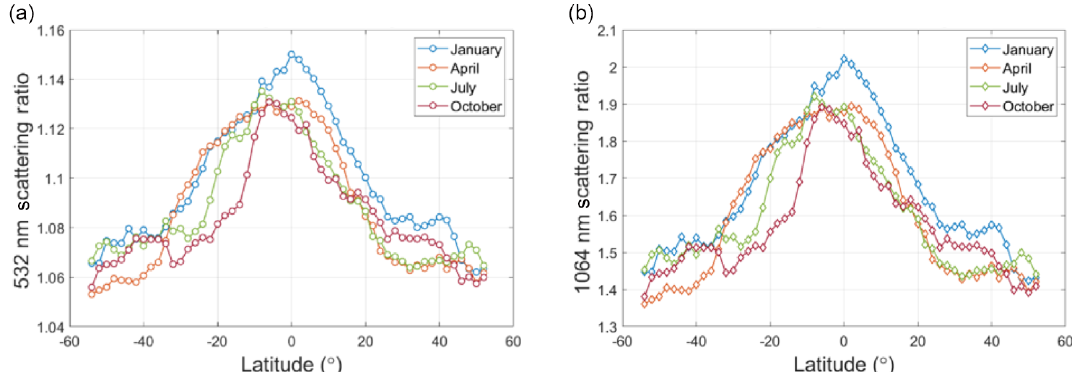
Figure 2. The 532nm scattering ratios measured by CALIOP within the CATS calibration region (a) and the 1064nm scattering ratios estimated from the 532nm retrievals (b) from 2016. These plots show the temporal and latitudinal variability within the calibration region where 1064nm estimated scattering ratios can range from below 1.4 to above 2.0 depending on the time of year and geographical